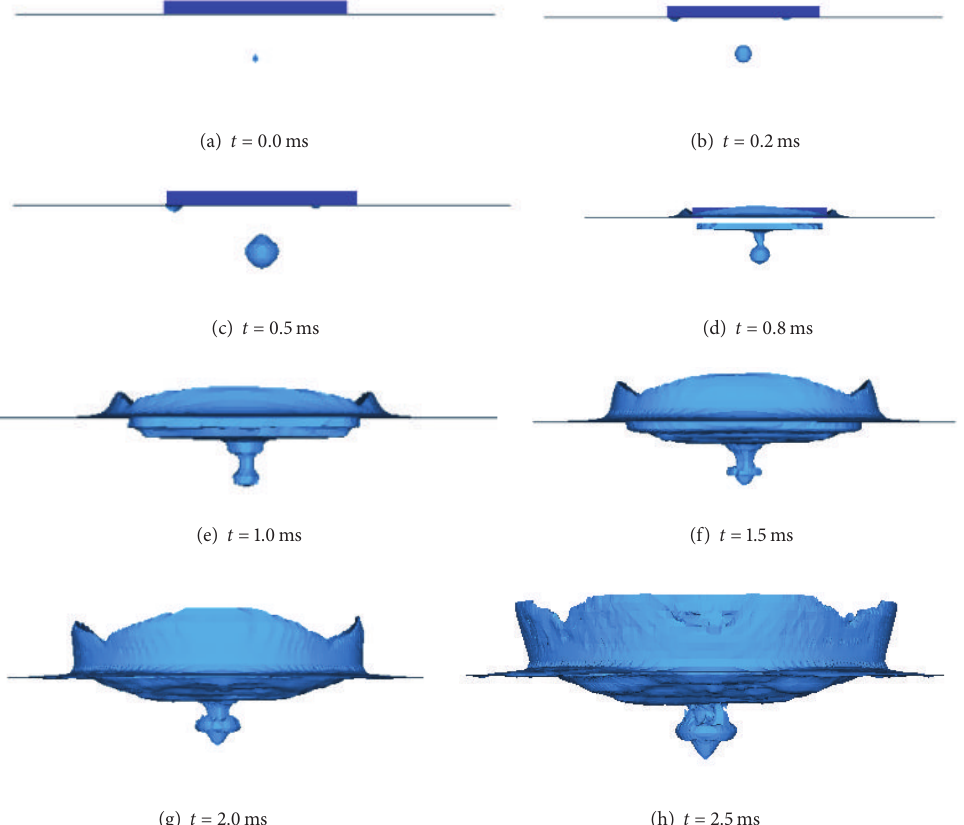
Figure 12: Bubble shape state of case 2 ( W = 0.05 kg, d = 0.3